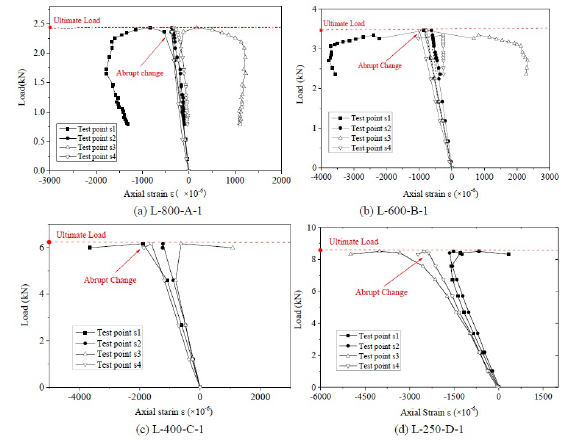
Figure 4: Load-strain curves for tubes of different lengths